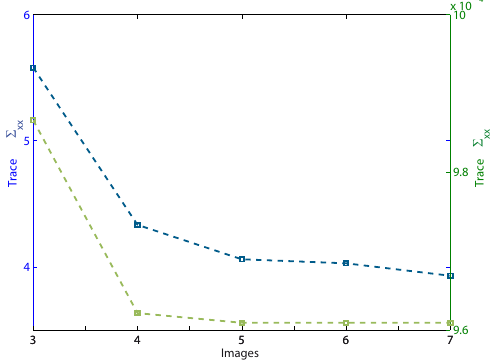
Figure 4: Trace criterion of the covariance matrix Σ first 161 estimated object coordinates (blue) and of the exterior orientation parameters of the first two images (green) over five subsequent epochs of incremental bundle